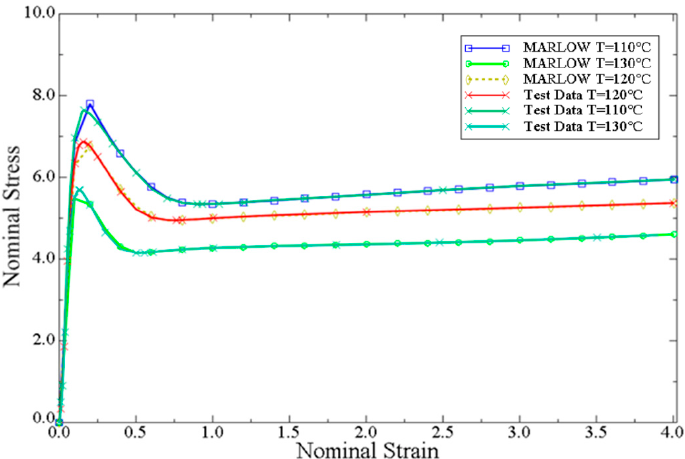
Figure 12. Fitting of stress-strain test values and Marlow curves at different temperatures.